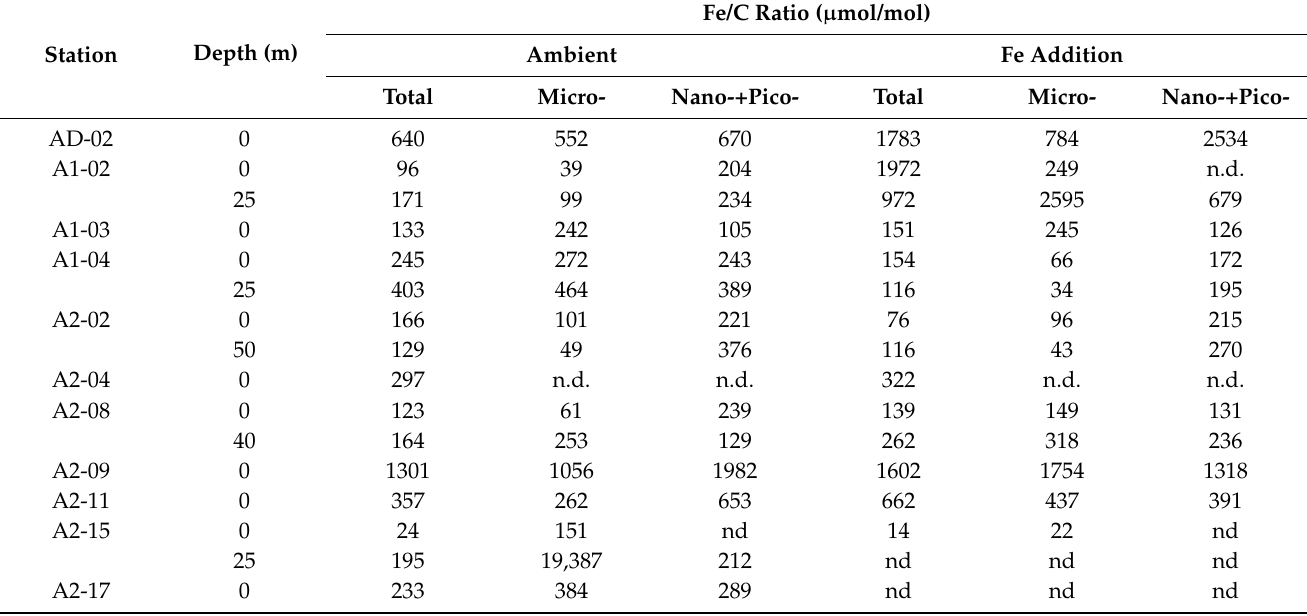
Table 2. The Fe/C ratios of phytoplankton absorbing DFe and DIC in ambient seawater and with Fe addition. Note: nd represents no